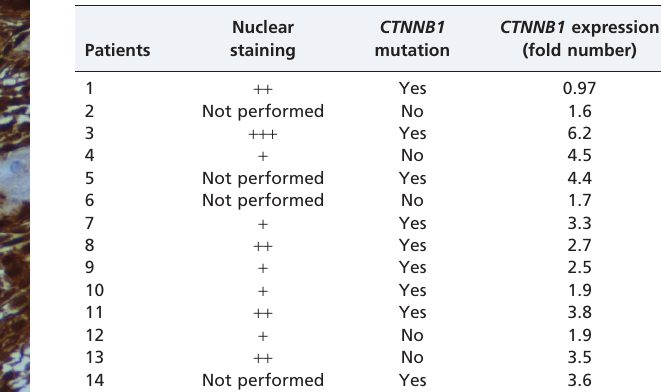
Table 2 - Immunohistochemical staining for b -catenin expression, the mutational analysis and the expression of CTNNB1 in adamantinomatous